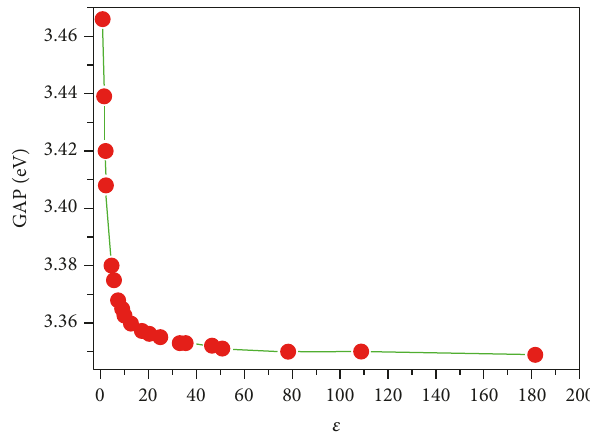
Figure 4: Gap energy as function of the dielectric constant values.